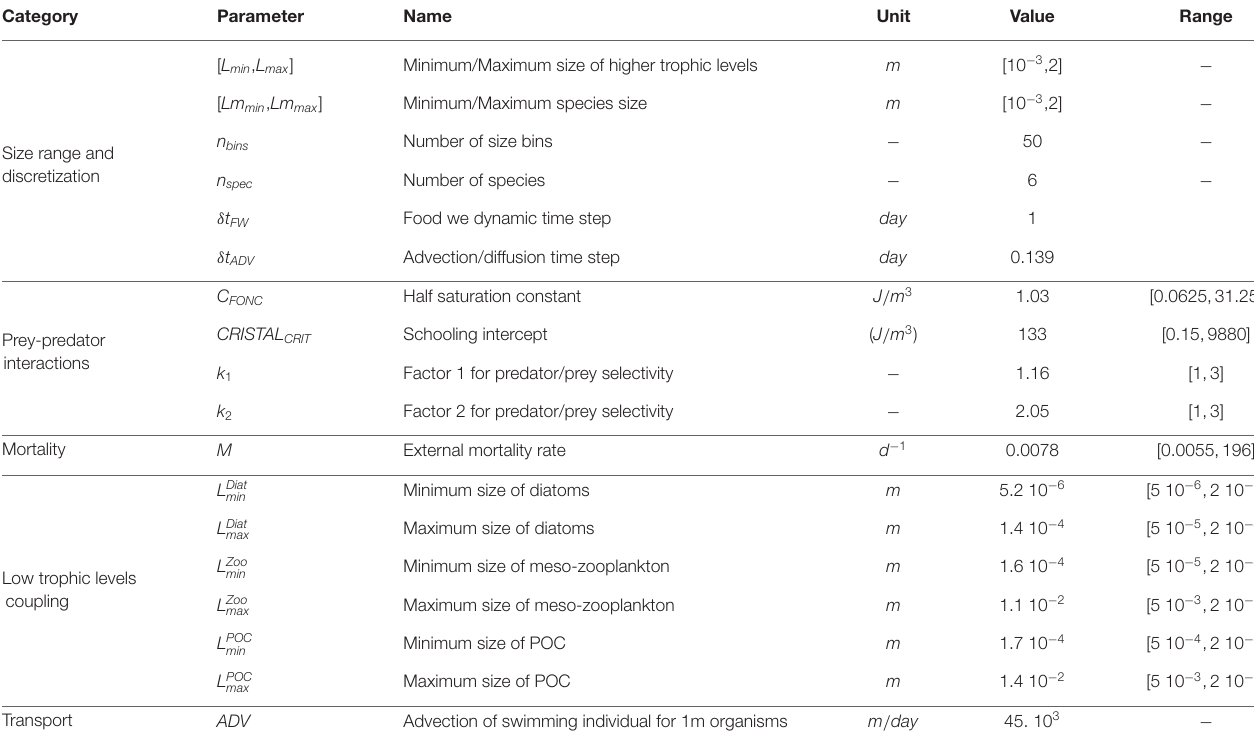
TABLE 1 | Parameters in APECOSM-CC referenced in the main text.